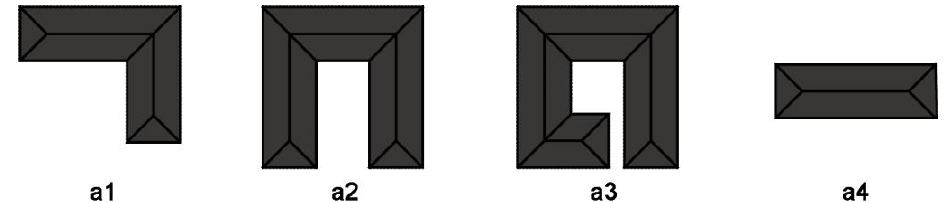
Figure 4. Main house types (A) Reprinted/adapted with permission from Ref. [3]. 2018, Donghwa Shon: These are classified according to the plan of the main house and the shape of facade is different for each type.